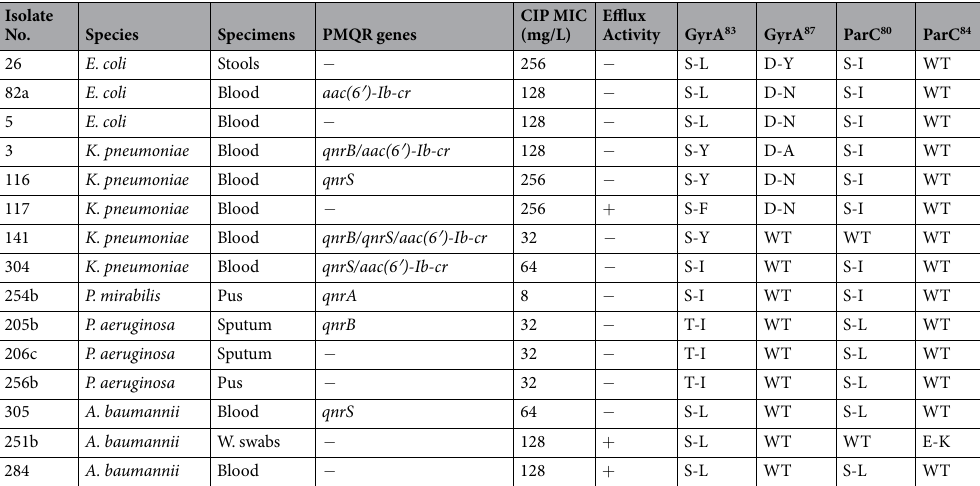
Table 2. Distribution of CIP resistance mechanisms including target site mutations, PMQR determinants, and efflux activity among the tested clinical isolates. W. swab; wound swab, PMQR, Plasmid-mediated